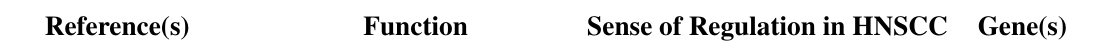
Table 1. Summary of illustrative findings related to invasiveness from gene-expression profiling studies in HNSCC.